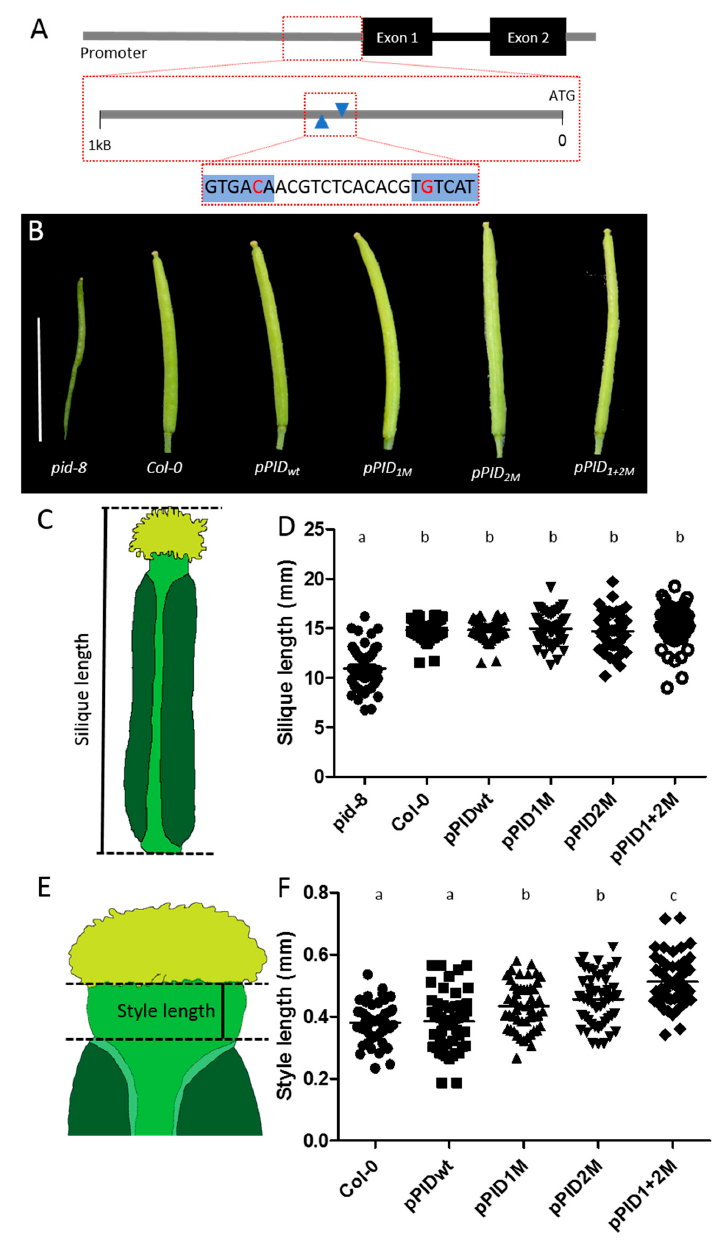
Figure 1. All four promoter variants can rescue the pid-8 fruit phenotype. However, rescue lines differ significantly in style length. ( A ) Schematic representation of the regulatory region indicating the location and sequence of the two AuxREs (blue). The nucleotides that have been mutated are highlighted in red. ( B ) Representative siliques for each promoter variant construct. Scale bar = 10 mm. ( C ) Silique length describes the length of the fruit from the lower edge of the valves to the tip of the stigmatic tissue. ( D ) Silique length measurements show that all promoter variants can rescue the pid-8 fruit length phenotype, and none of the lines differs significantly from the wild type (N = 50). ( E ) Style length is measured as the distance from the most apical part of the valves to the underside of the stigmatic tissue. ( F ) Style length measurements show that styles are significantly longer in lines with mutated AuxRE elements in the PID promoter compared to wild-type and the positive pPID wt line (N = 50). a,b indicate significant differences according to multiple comparison.